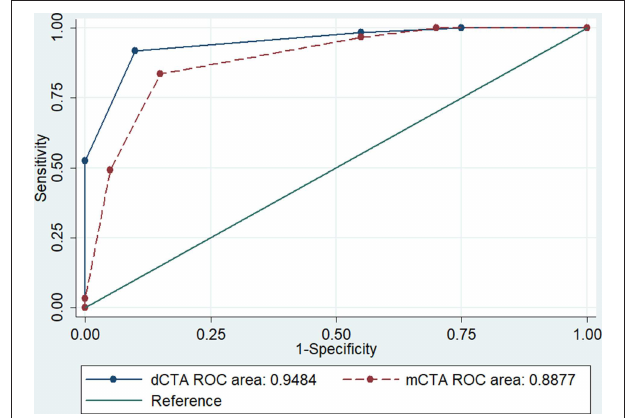
FIGURE 3 | The receiver operating characteristic analysis. The ASPECTS collateral scale classifies well patients with target mismatch on both dCTA and omCTA. The cutoff point with best prediction is score 3, with 0.92 sensitivity and 0.95 for specificity with dCTA; and 0.84 sensitivity and 0.89 for specificity with omCTA. AUC, area under the